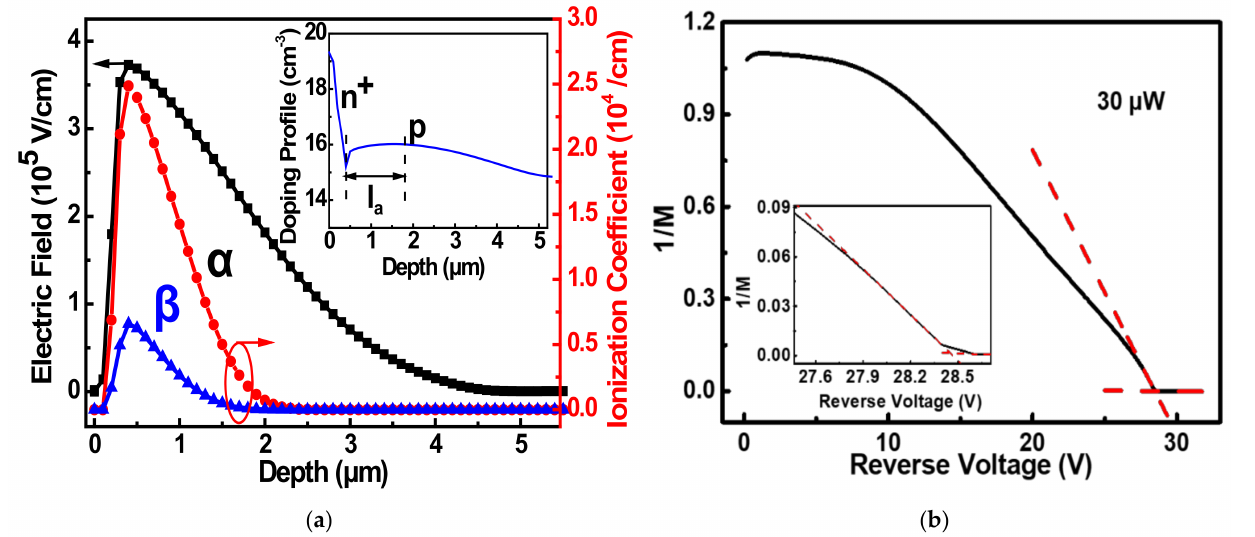
Figure 3. Electric field simulation and 1/ M versus reverse voltage. ( a ) α (red symbol), β (blue symbol), and electric field (black symbol) distribution at V br . Inset: Extracted doping profile of the structure. ( b ) 1/ M as a function of reverse bias at 30 µ W (black line) and fitting curves (red dash line) from Figure 2a. Inset: Enlarged view at the